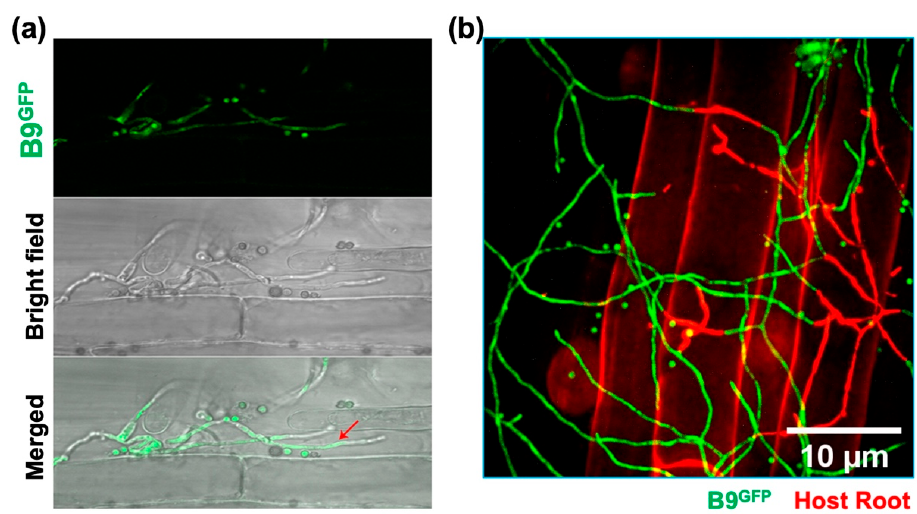
Figure 5. Confocal micrographs of Choy Sum roots incubated with cytosolic eGFP-expressing B9 strain of P. citrinum . Choy Sum roots were incubated with 1 × 10 4 spores/mL at day 5 post germination. The root colonization was analyzed at 1, 2 and 3 days after incubation. Confocal microscopic images of Choy Sum roots incubated with B9 GFP strain ( a , b ). Root tissue was counter-stained with Propidium iodide. GFP, green fluorescent protein; bright field, host root, Propidium iodide (PI) staining, merge, composite of the GFP, PI and bright field channels.